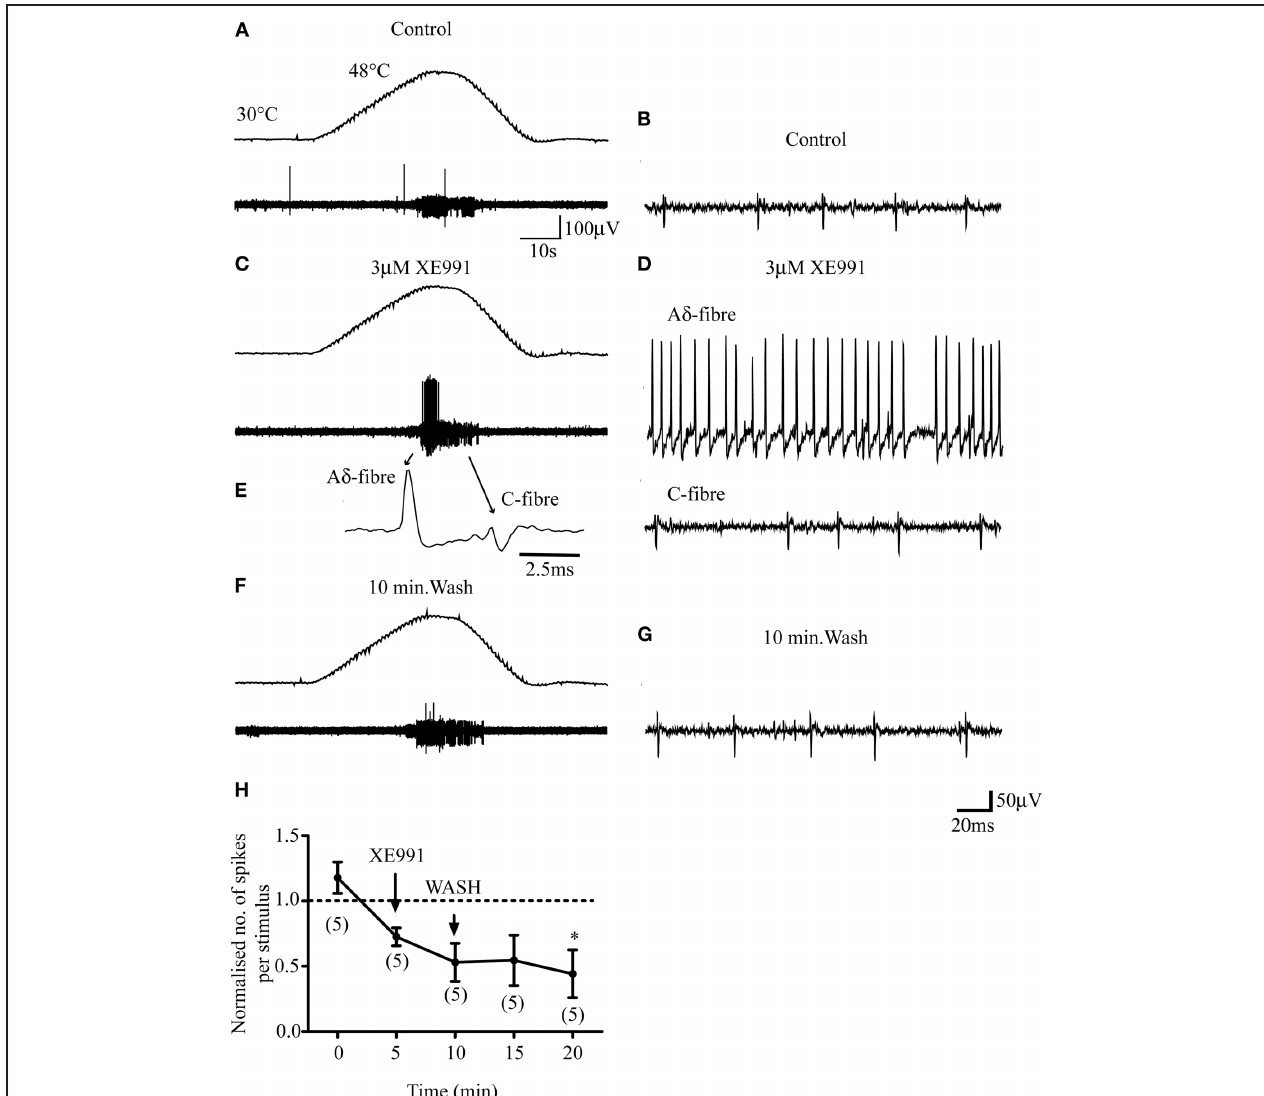
FIGURE 5 | M-channel inhibition does not sensitize C-fibers to subsequent heat stimulation. (A–F) 3 μ M XE991 does not facilitate the response of a CMH-fiber (small fiber) but recruits an A δ -fiber (large fiber) that was unresponsive to heat stimulation in control. The top panels in A , C, and F show the noxious heat ramps that ramp from 30 ◦ C to 48 ◦ C. (E) Profile of the A δ - and C-fiber on an expanded time-scale. (B, D, and G) . Activities of the fibers on an expanded time-scale in control, XE991 and following 10min